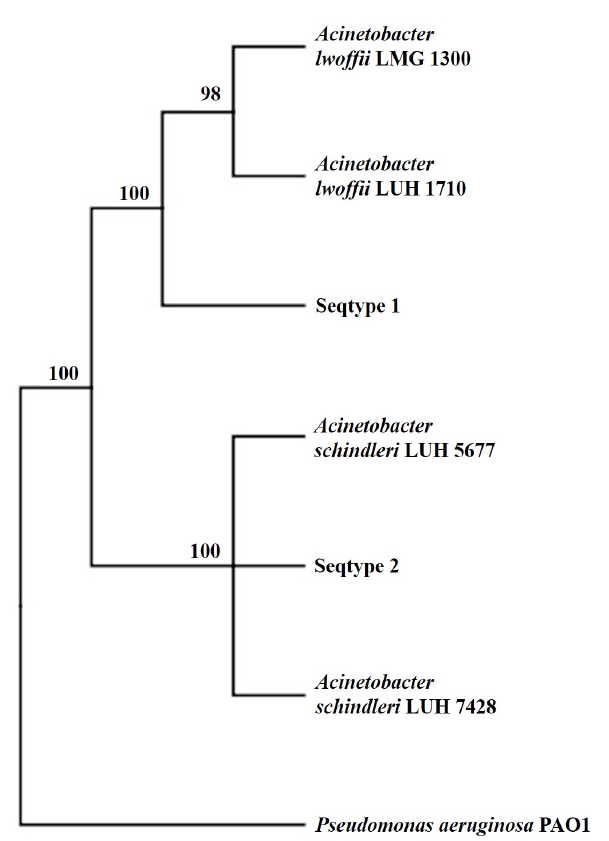
Fig. 2. Phylogenetic relationships between the two isolates (seqtype 1 – Acinetobacter lwoffii isolate S459 and seqtype 2 – Acinetobacter schinderi isolate S35) and other members of the genus Acinetobacter inferred from partial rpoB DNA sequences. Numbers at nodes represent bootstrap values out of 1000 resam- plings that were greater than 50%. The tree was outgroup rooted with Pseudomonas aeruginosa strain PA01